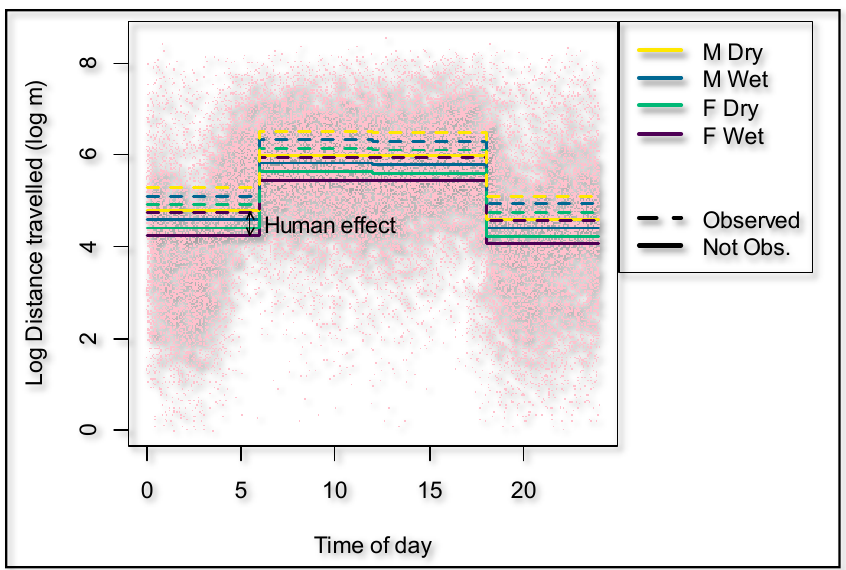
Figure 3. Effect on the distances traveled by giraffes depending on human observers present vs. not present as well as season and time of the day.